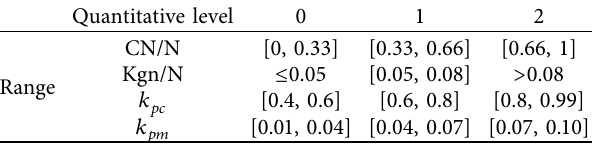
Table 1: Quantization values of fuzzy variables.